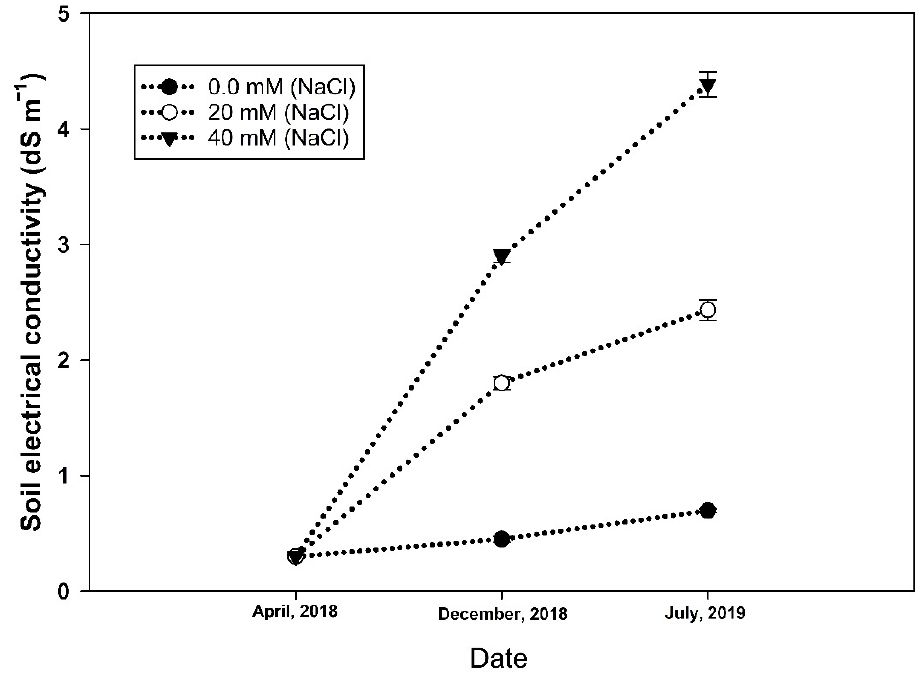
Figure 2. Soil electrical conductivity during the study period, 2018–2019. Samples were from ‘Beaudine’ uninoculated pots.